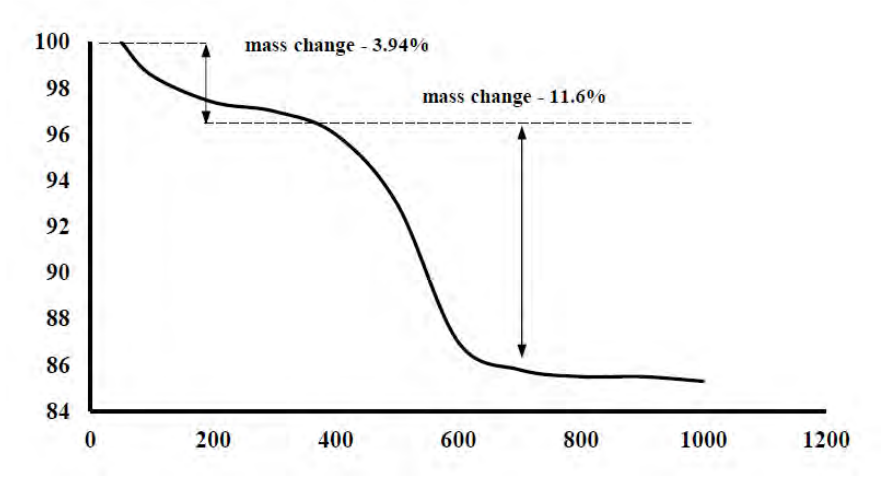
Figure 2. TGA of